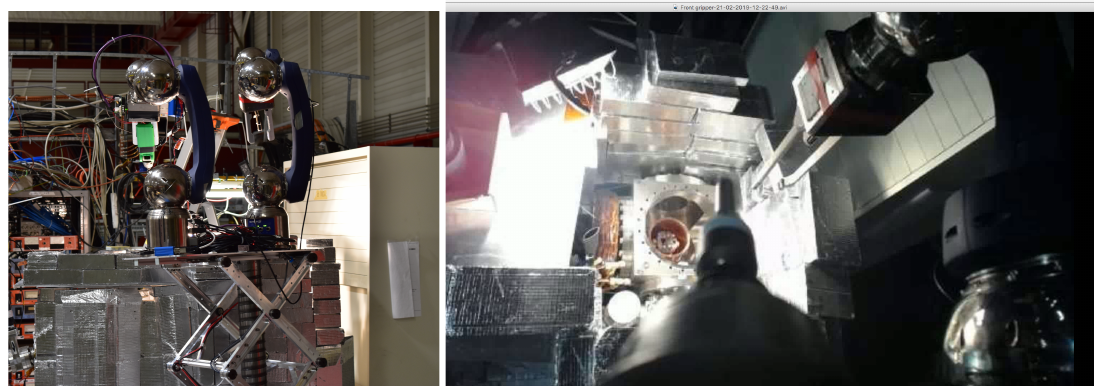
Figure 6. Real interventions with dual-arm configurations.